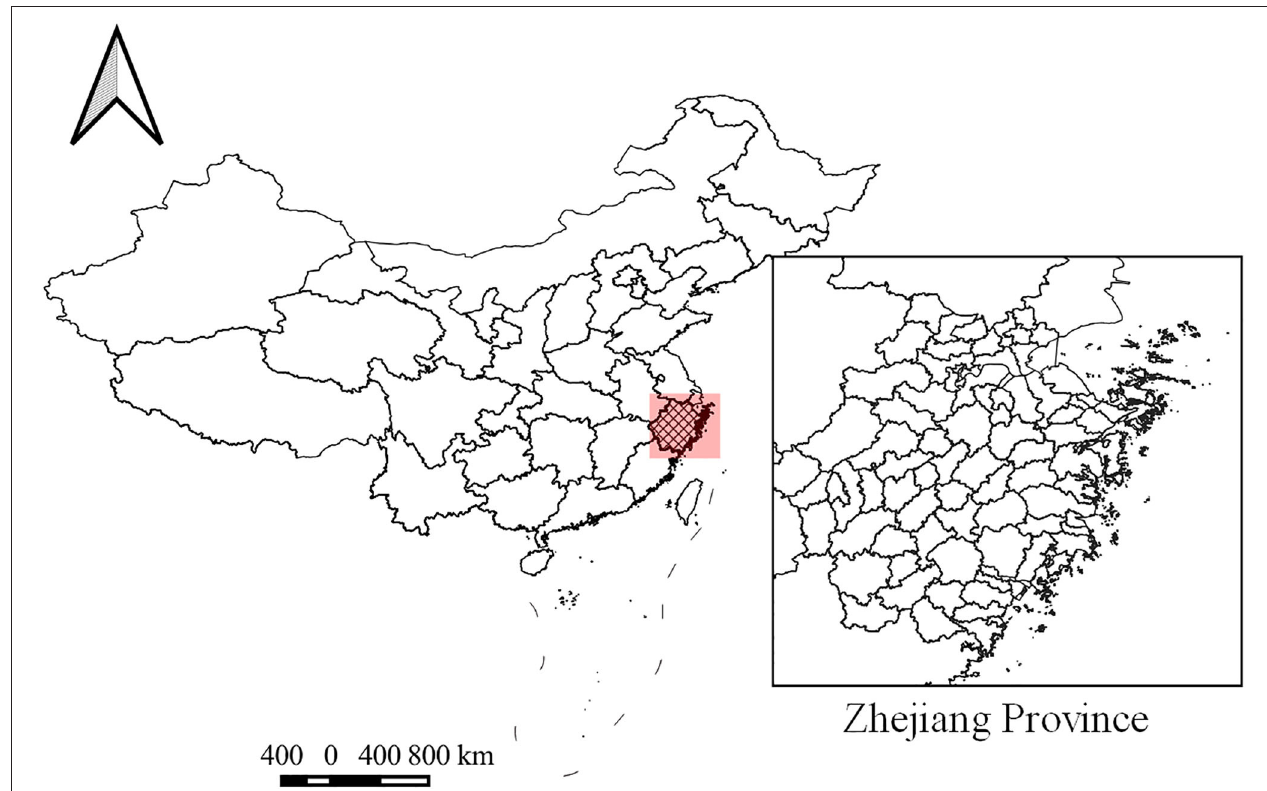
FIGURE 1 | The location of Zhejiang